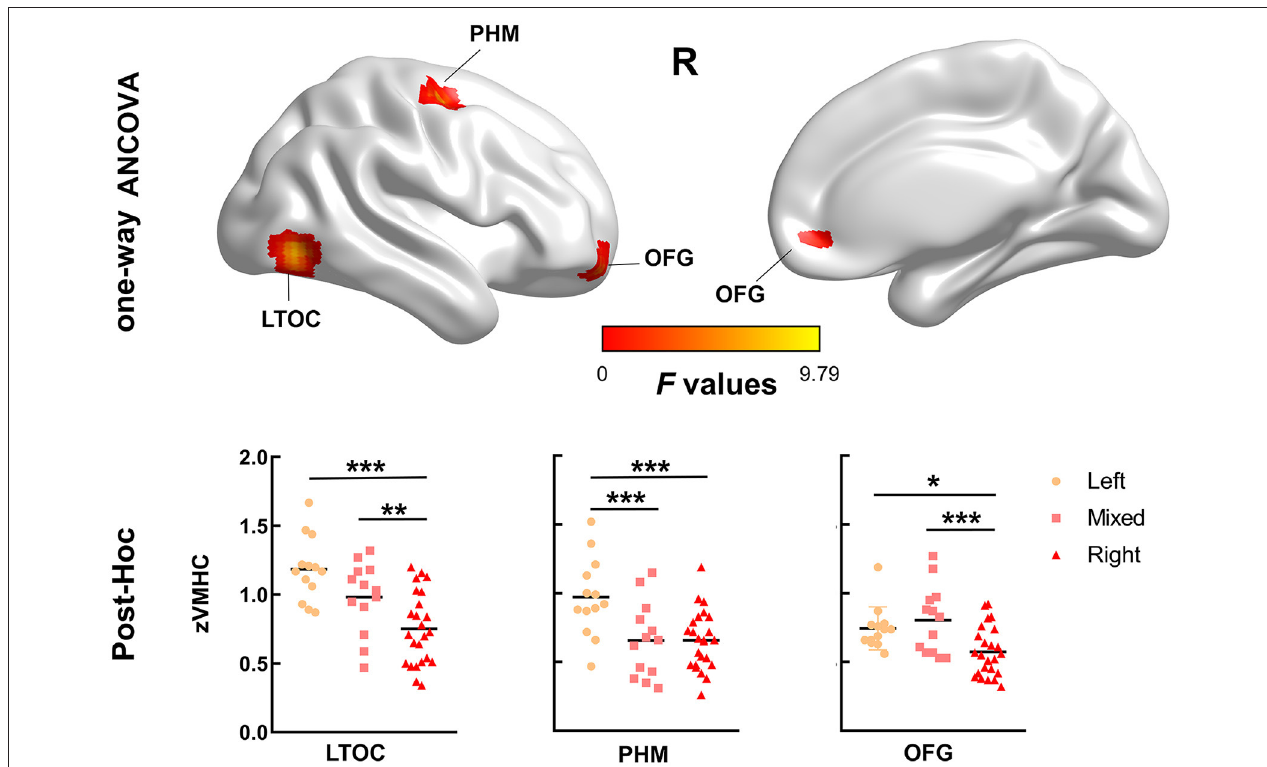
FIGURE 1 | Brain areas with significant differences in voxel-mirrored homotopic connectivity (VMHC) values among the three groups. There were significant differences in VMHC among the three groups in lateral temporal-occipital cortices (LTOC), primary hand motor region (PHM), and orbitofrontal cortex (OFC) (family-wise error, FWE cluster corrected, p < 0.050). We extracted the VMHC values of the above significant clusters and performed post-hoc analysis to determine the between-group differences. Specifically, both left-handedness (LH) and mixed-handedness (MH) showed enhanced interhemispheric functional connectivity in LTOC and OFC compared with right-handedness, and the interhemispheric functional connectivity of LH in the PHM region was enhanced than that of mixed/right-handedness. (*: p < 0.050, **: p < 0.010, ***: p < 0.001).